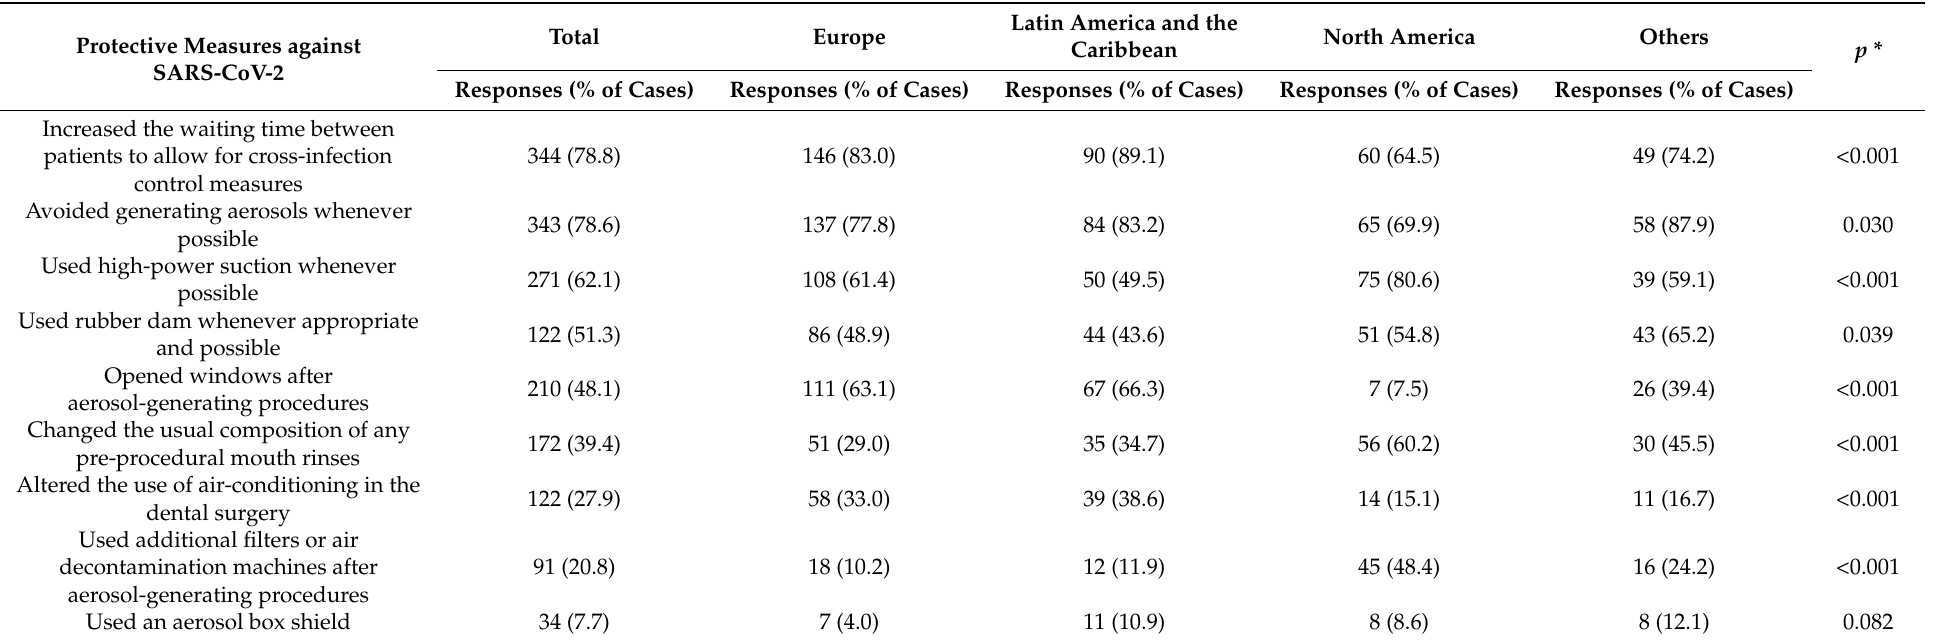
Table 5. Implementation of protective measures against SARS-CoV-2 in the dental office, according to the responding dentists’ geographical area of origin ( n = 436). Protective Measures against